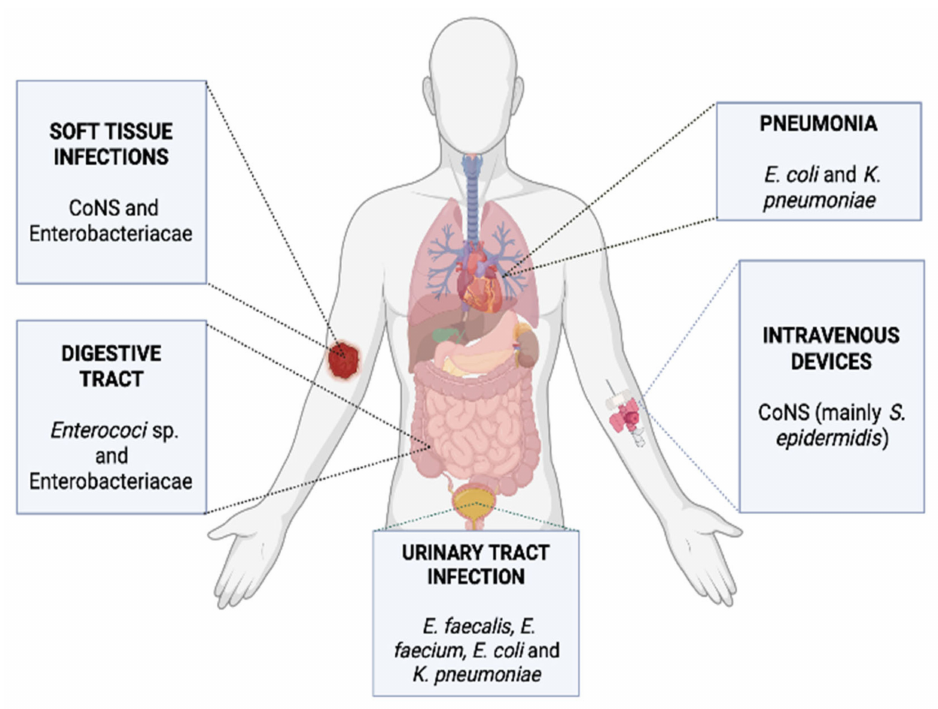
Figure 1. Most common microbes implicated in polymicrobial sepsis and their sources.